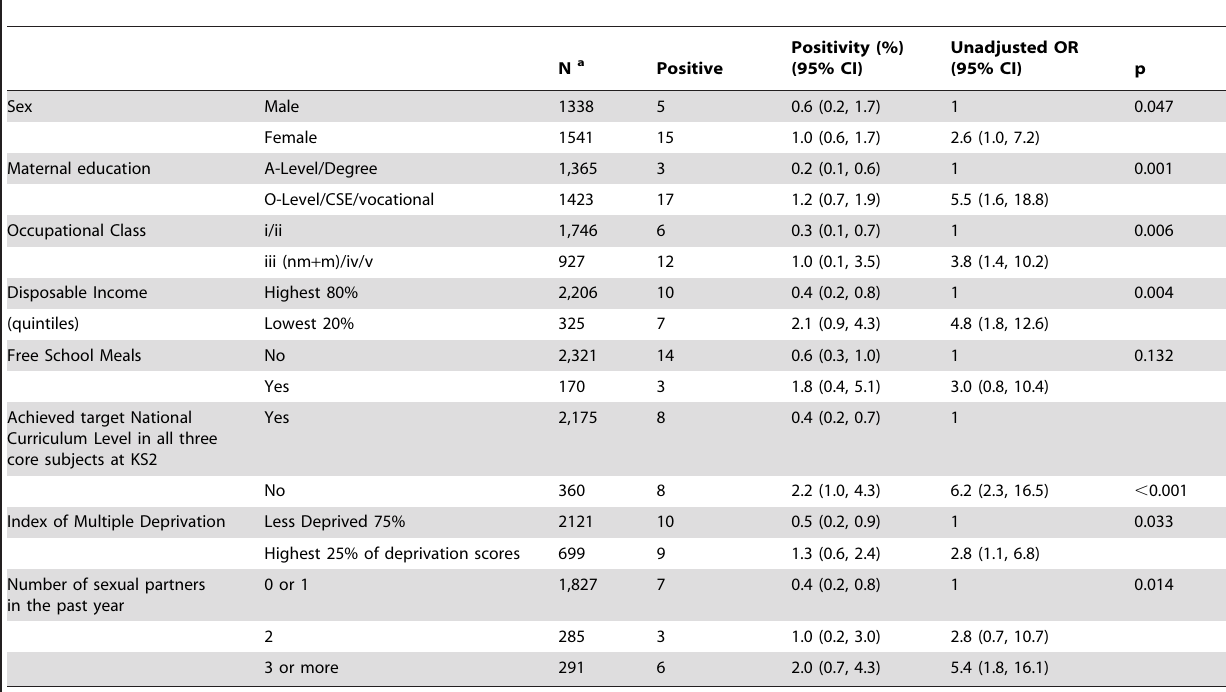
Table 4. Unadjusted associations between chlamydia infection and gender, socioeconomic position, education and number of sexual